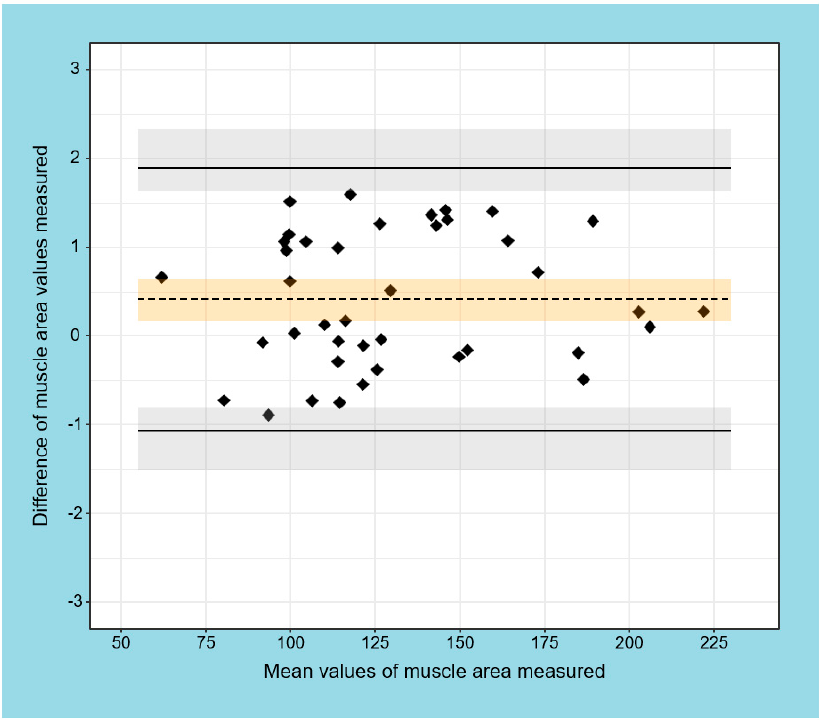
Figure 6. Bland–Altman plot of muscle area measured by Horos and LIFEx software. The limits of agreement are shown as solid, black lines with 95% exact CI (light grey area); bias (dashed black line) with 95% CI (light orange area).